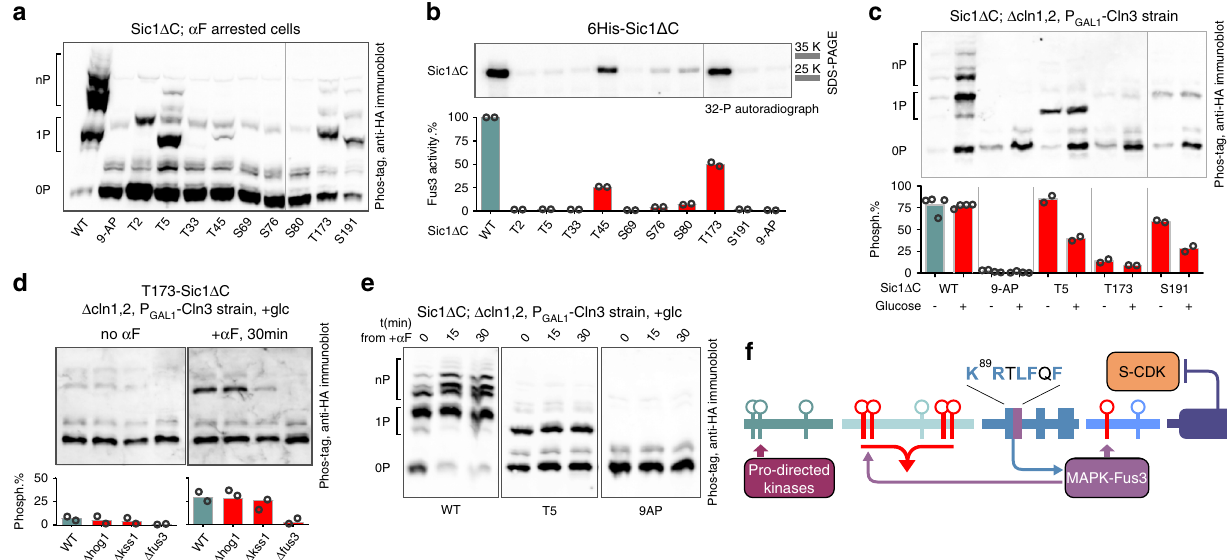
Fig. 4 Analysis of the phosphorylation pattern of Sic1 in G1-arrested cells. a A Phos-tag western blotting analysis of the phosphorylation of Sic1 Δ C-3HA versions containing only the indicated CDK consensus sites, with all other CDK sites mutated to alanines. All western blots in this fi gure were performed using the 3HA-tagged Sic1 Δ C versions expressed under ADH1 promoter. b In vitro kinase assay showing phosphorylation of Sic1 versions with single phosphorylation sites by MAPK Fus3. An autoradiograph of an ordinary SDS – PAGE is shown. Bar diagrams in this fi gure represent the mean level derived from the data of two values that are obtained from two independent experiments. The values are plotted individually by the open circles. c The phosphorylation shifts of Sic1 Δ C versions carrying only the phosphorylation sites T5, T173, or S191 visualized by Phos-tag western blotting of the cell extracts obtained from G1-arrested cultures. The cells were arrested in G1 by suppression of GAL-CLN3 expression by addition of glucose in a Δ cln1 Δ cln2 strain background. The Sic1 Δ C version with all nine CDK consensus phosphorylation sites mutated to alanines was used as a control. The shift values were calculated as percentage of quanti fi ed phosphorylated bands from the sum of non-phosphorylated and phosphorylated bands. d The effect of the pheromone on T173 phosphorylation shift in cells arrested in G1 as in c . Strains expressing the T173 – Sic1 Δ C in wild-type and MAPKs FUS3, HOG1, and KSS1 deletion backgrounds were compared. Mean values presented in the chart were calculated as in c , and are obtained from two independent experiments. e The G1 arrest was induced as in c and d , then α -factor was added to the cultures and timepoints collected after indicated time The wild-type Sic1 Δ C, T5-Sic1 Δ C, and 9AP-Sic1 Δ C strains were used. f A diagram showing MAPK Fus3 input phosphorylation sites, MAPK docking motif KRXXFXF overlapping with the S-CDK docking motif RXLF, and T5 as the input site for generic proline-directed kinase signal. The experiments for a – e were performed twice with similar result. The full gel radiographs and blots are presented in Supplementary Fig. 7. Source data are provided as a Source Data fi